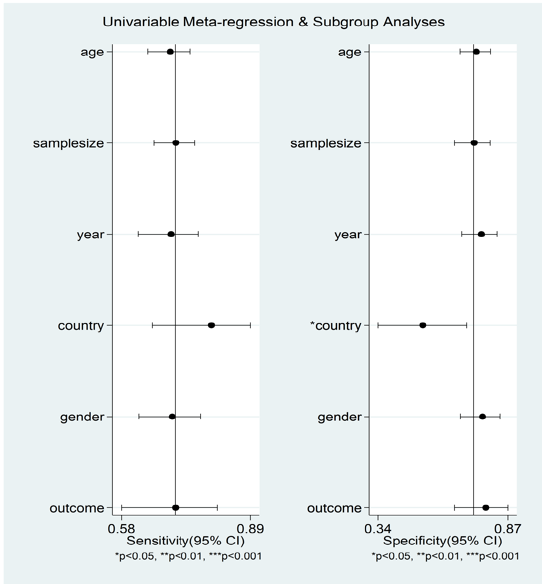
Figure 20. Forest plots of sensitivity and specificity for the study level covariates included in the univariate meta-regression model.